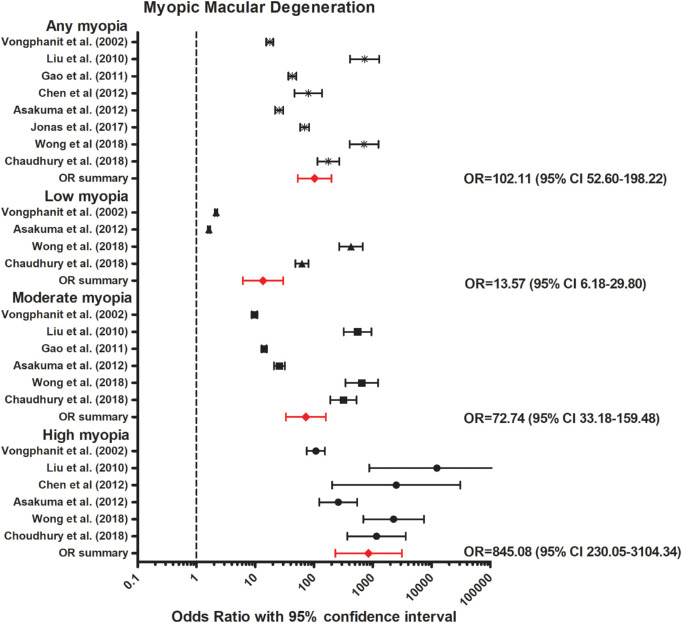
Forest plot of MMD in any myopia (random effects model; Q = 16.1; I2 = 56.5); low myopia (random effects model; Q = 27.6; I2 = 85.5); moderate myopia (random effects model; Q = 18.0; I2 = 72.2), and high myopia (random effects model; Q = 5.2; I2 = 4.3). Red lines with diamond represents the summary OR per myopia category. Summary OR for myopia categories are as follows: any myopia OR, 102.11 (95% CI, 52.60–198.22); low myopia OR, 13.57 (95% CI, 6.18–29.79); moderate myopia OR, 72.74 (95% CI, 33.18–159.48); and high myopia OR, 845.08 (95% CI, 230.05–3104.34).